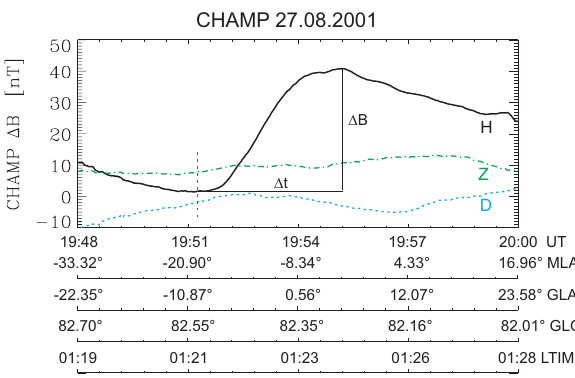
Fig. 1. Example of an SC recorded by the CHAMP magnetome- ter. H , D , Z are the three components measured onboard CHAMP. The dashed red line marks the onset of the SC, 1B is its amplitude (listed in Table 1 for all